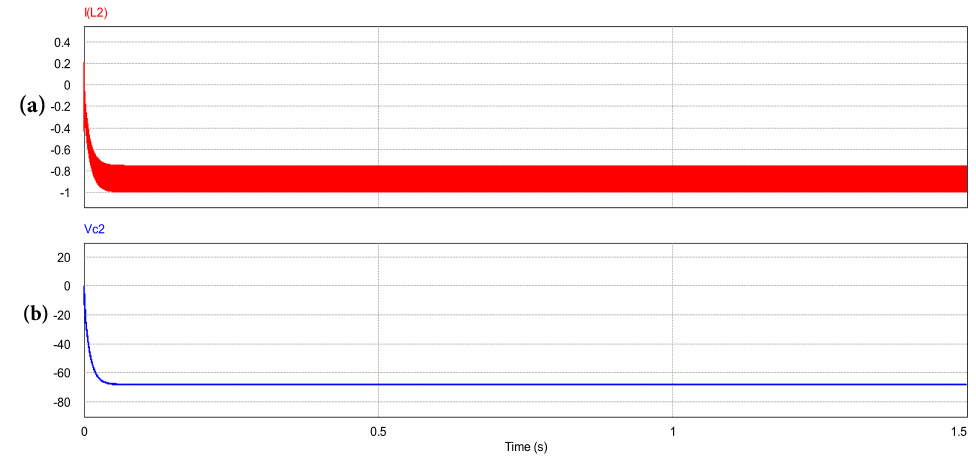
Figure 21. Cuk converter performing in closed loop. ( a ) inductor two current, ( b ) capacitor two voltage. Inductor two curren ripple is 20% nominal value, this condition avoids undesirable effects in light spectrum. Voltage output, v C 2 , performs a smooth start and reminds regulated during simulation time.